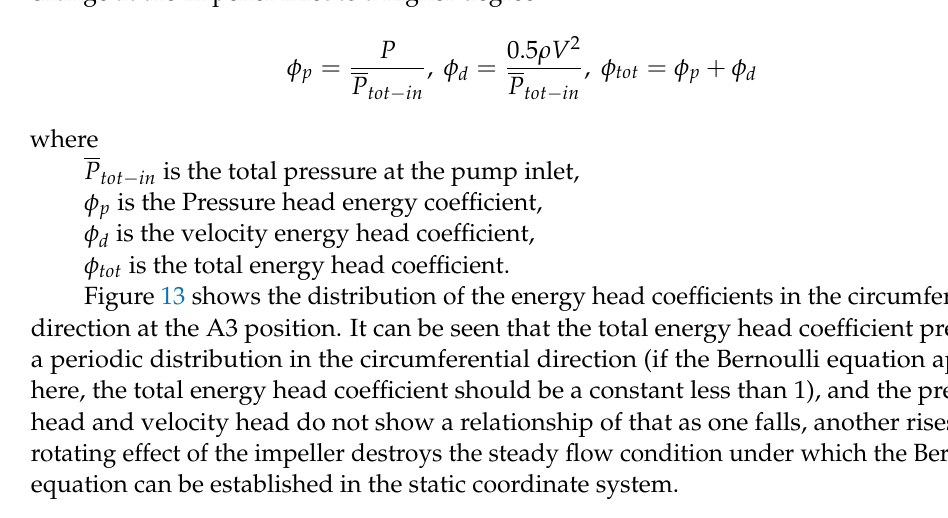
Figure 12. Distribution of impeller inlet pressure coefficient at different radial coefficient in plane A. The energy head coefficients are defined as follows to represent visually the energy change at the impeller inlet to a higher degree.